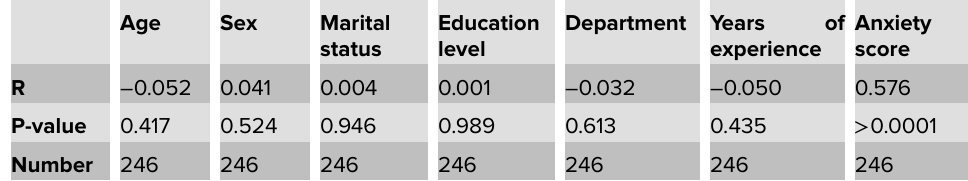
Table 5: Correlation between depression score and baseline